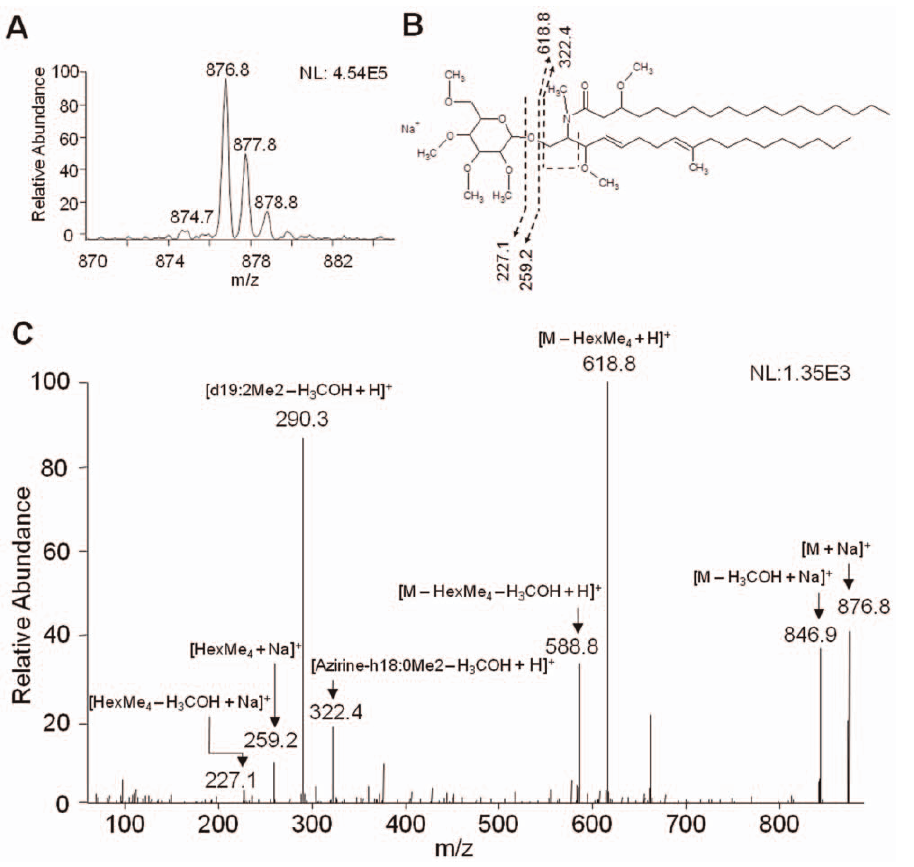
Figure 4. Neutral glycolipid analysis of Pb3 and Pb18 extracellular vesicles. Glycolipid-enriched fractions from total lipids were permethylated and analyzed by ESI-MS/MS. (A) Full-scan spectrum by ESI-MS in the positive-ion mode of Pb3 extracellular vesicle glycolipids. (B) Proposed fragmentation and structure of the major glycolipid identified in Pb3 and Pb18 extracellular vesicles. The positions of unsaturation, hydroxyl and methyl groups of the ceramide were based on the structure proposed by Toledo et al. (1999). (C) MS/MS spectrum of the major glycolipid species at m/z 876.8. The number at the top right corner indicates ion intensity. m/z , mass to charge ratio. The same glycolipid species have been identified in Pb3 and Pb18, however since the analysis is qualitative we cannot assure that are not quantitative differences.